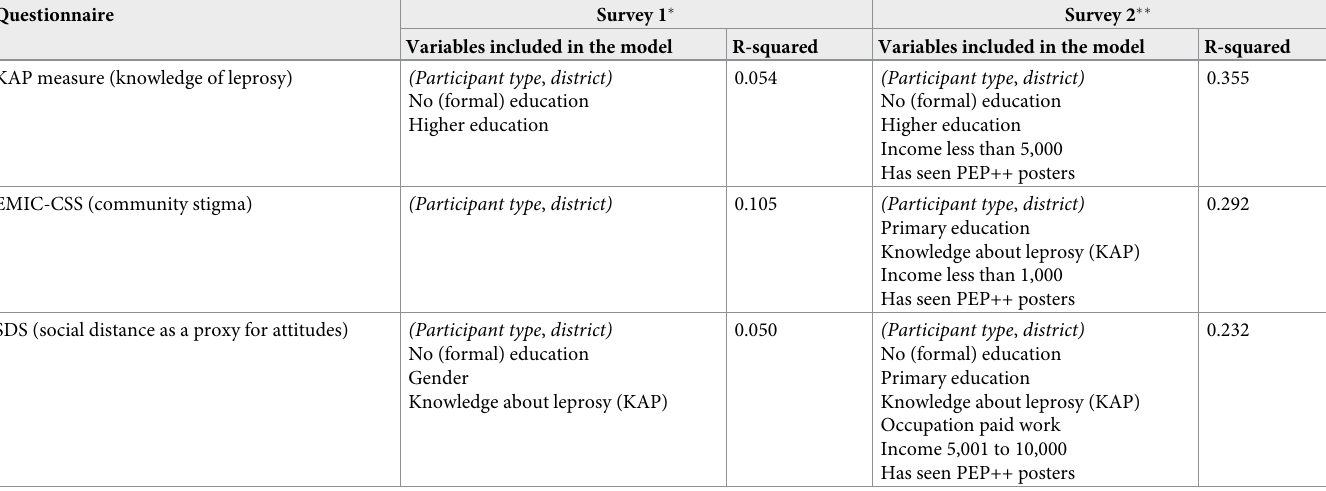
Table 5. Correlations between level of knowledge (KAP score) about leprosy, community stigma (EMIC-CSS), social distance (SDS) and the other variables in the dataset including data of persons affected by leprosy, close contacts and community members. Participant type and district were included in all models to control for